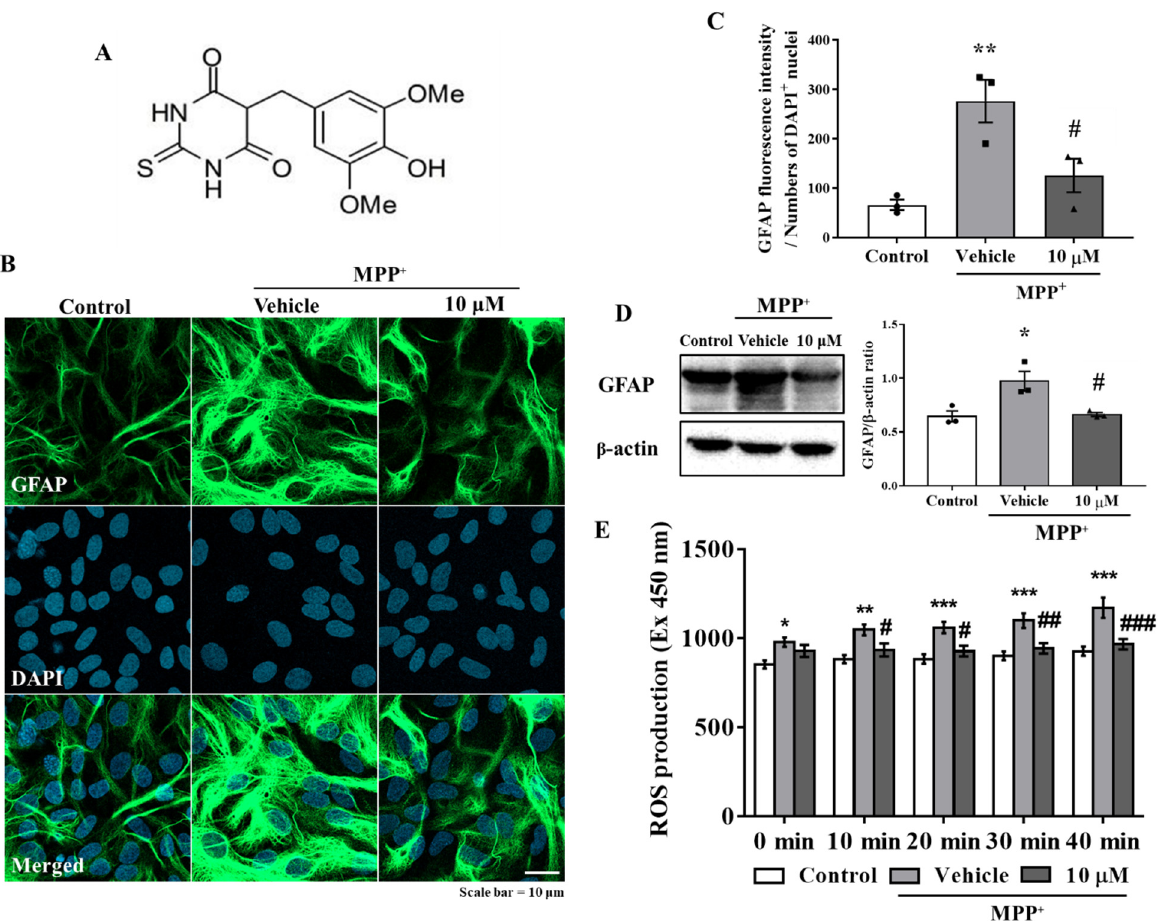
Figure 1. MHY2699 reduced MPP + -induced glial activation and ROS levels in primary astrocytes. ( A ) Chemical structure of MHY2699. ( B ) Representative images showing that MHY2699 diminished GFAP fluorescence intensity (an astrocyte marker). The cells were counterstained with DAPI. Scale bar = 10 μ m. ( C ) The fluorescence intensity of the GFAP protein was quantified ( n = 3). ( D ) Western blot analysis confirmed the inhibitory effect of MHY2699 on glial activation. Three independent experiments were performed ( n = 3). ( E ) ROS levels evaluated using DCF-DA dye showed that MHY2699 suppressed MPP ⁺ -induced oxidative stress in the primary astrocytes. The values are presented as means ± standard errors (SEM) ( n = 4). *** p < 0.001, ** p < 0.01, * p < 0.05 vs. naïve control, ### p < 0.001, ## p < 0.01, # p < 0.05 vs. MPP + controls (analyzed by ANOVA with Tukey’s multiple comparisons).